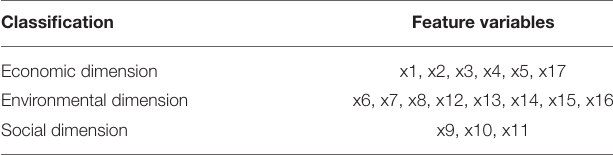
TABLE 2 | Classification of characteristic variables.